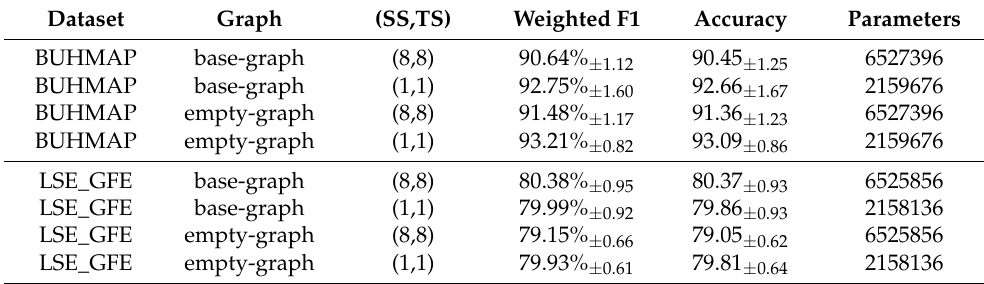
Table 9. Ablation study with one single scale in both spatial and temporal